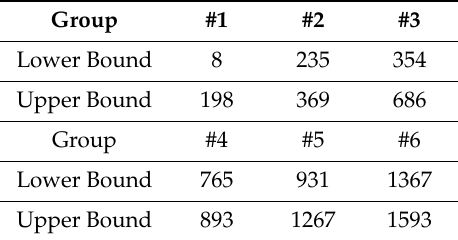
Table 3. Lower and upper bound parameters of each image